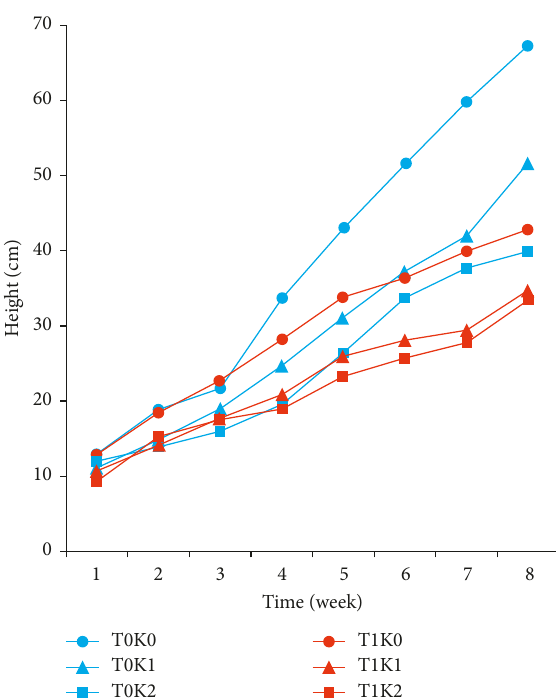
Figure 3: Average growth of